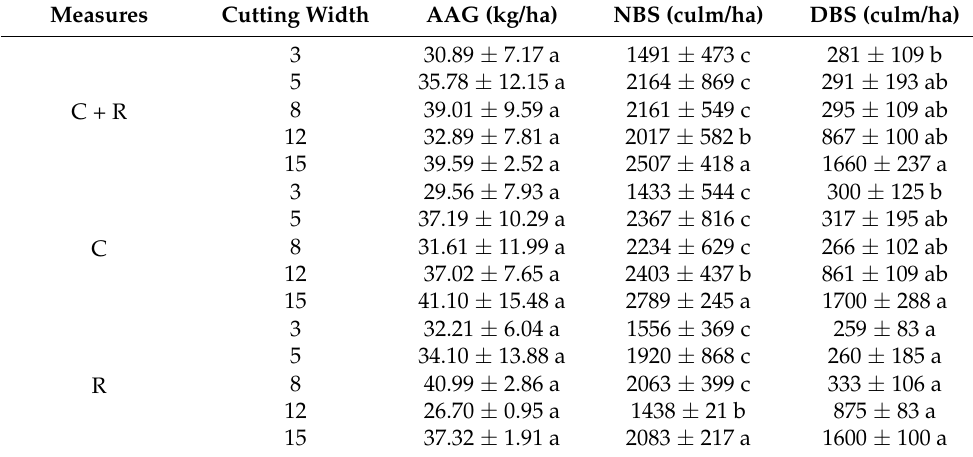
Table 4. Compare the stand characteristics of bamboo forest with different strip cutting and reserve zone.